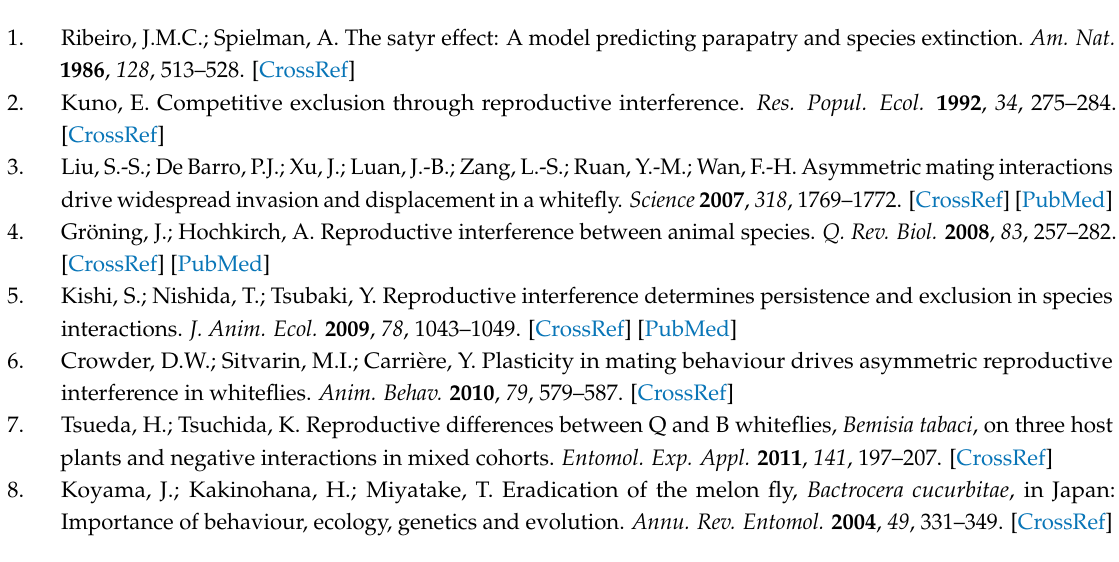
Table S1: Effective number of queen mating frequency for each bumblebee species.